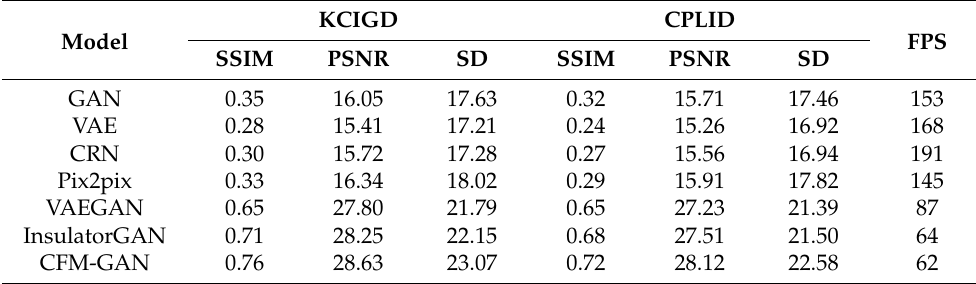
Table 5. SSIM, PSNR, and SD of various models. FPS is the number of images that are processed per second during the